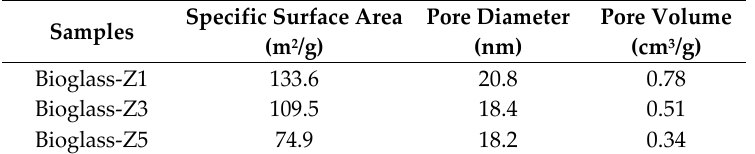
Table 1. Values of specific surface area, pore diameter, and pore volume for synthetic